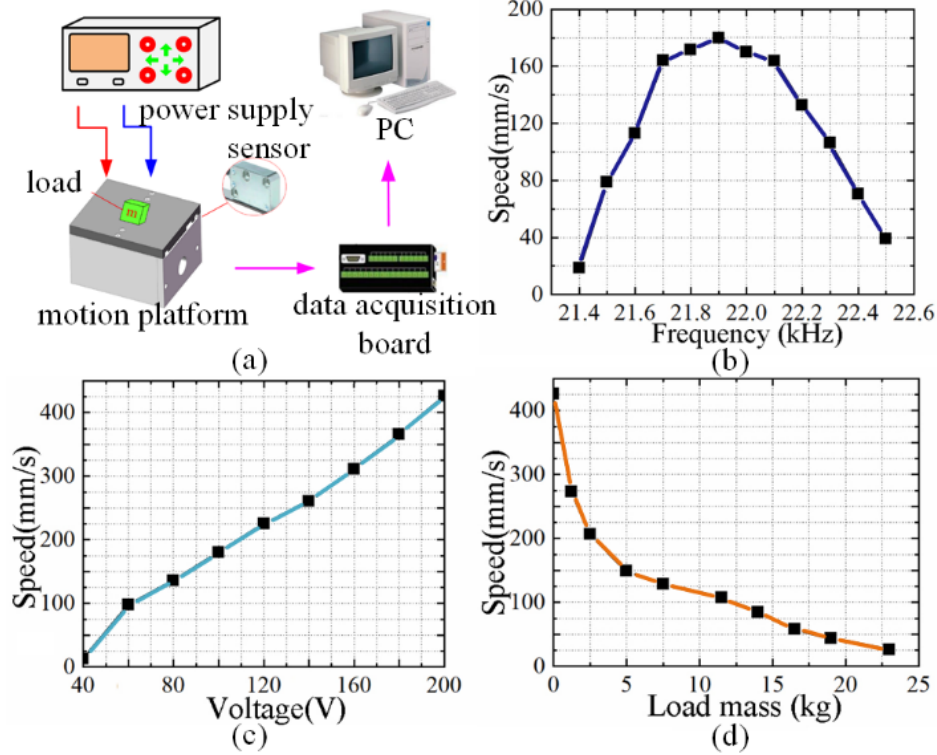
Figure 8. Linear platform system. ( a ) Appearance top view. ( b ) Internal structure.